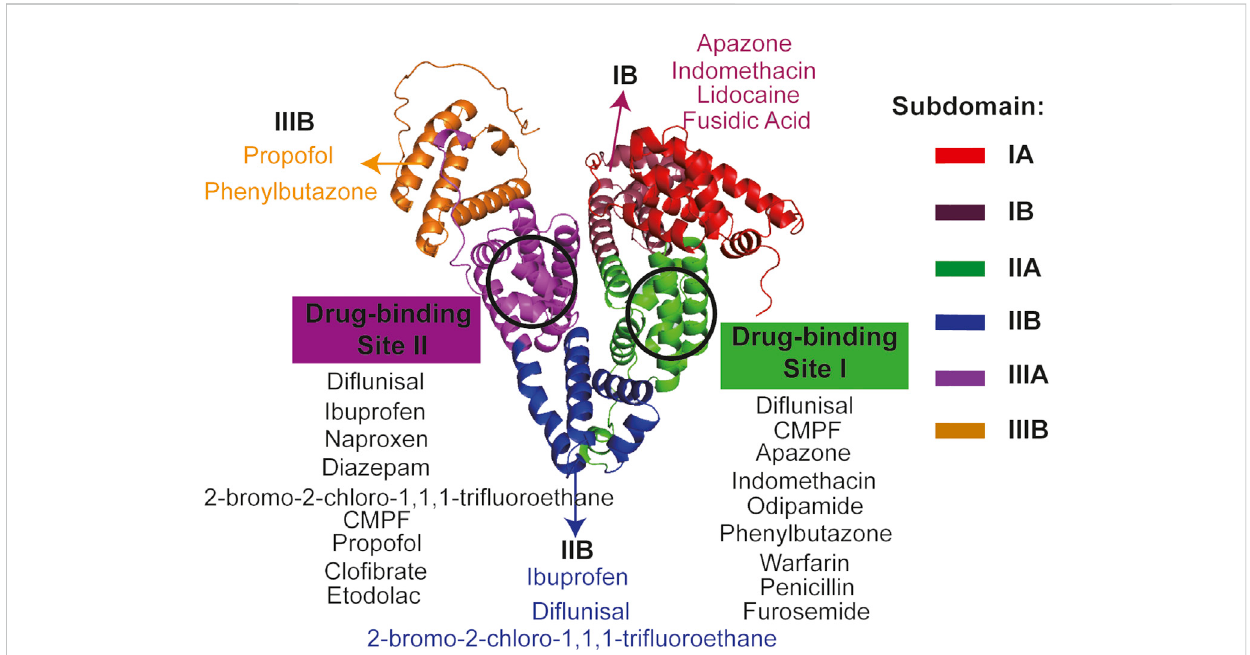
FIGURE 1 The crystal structure and drug-binding sites of human serum albumin. The crystal structure of human serum albumin is heart-shaped and divided into3mainregions,eachofwhichcanbedividedintotwosub-regions(Carteretal.,1989;Colmenarejo,2003).Sudlowetal. fi rstfoundthatdrug-binding sitesonalbuminwereconcentratedintworegions,siteIandsiteII,respectively(Sudlowetal.,1976).Thedetailedbindingregionsforthevariousdrugsare shown in thediagram (Bhattacharya etal., 2000;Petitpas etal., 2001;Colmenarejo, 2003; Kratz, 2008).Full name ofCMPF is 3-Carboxy-4-methyl- 5-propyl-2-furanpropionic